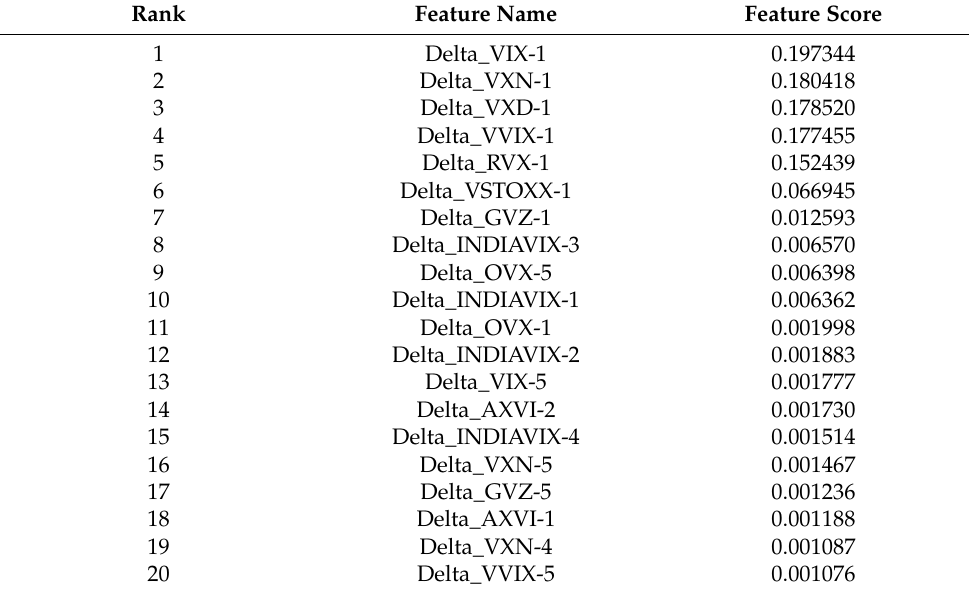
Table 7. Feature scores and rank generated from Random Forest.